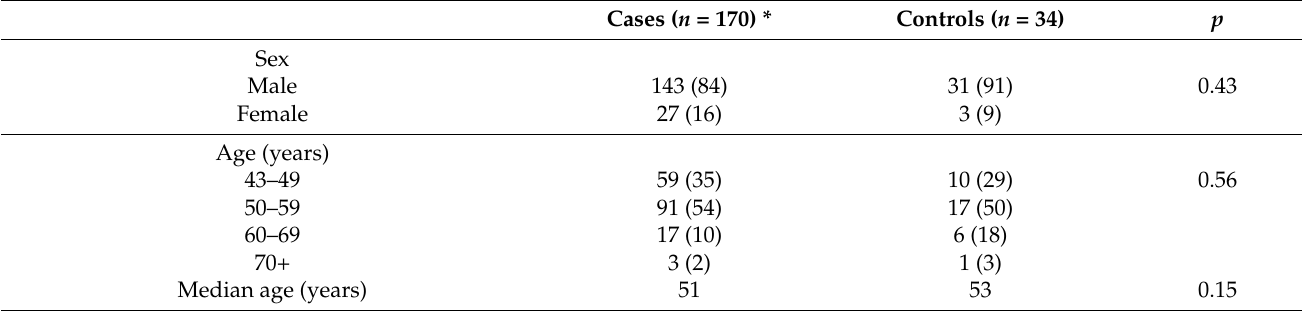
Table 1. Demographic, military and deployment characteristics of Caucasian GWI cases and controls, data are n (%). p -values were obtained by Chi-square, Fisher’s exact or Mann–Whitney U tests comparing the two